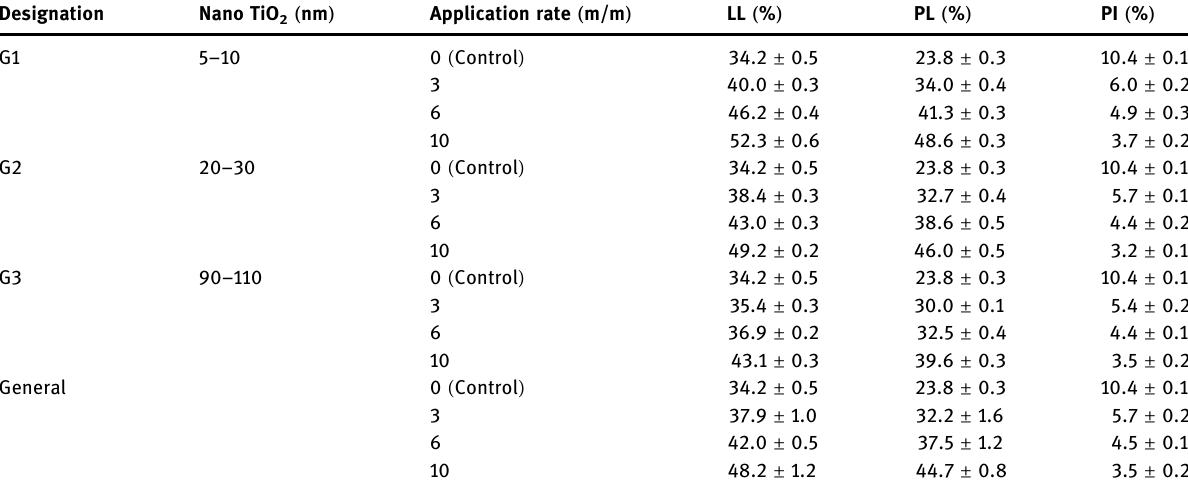
Table 4: E ff ect of nano TiO 2 application on liquid limit ( LL ) , plastic limit ( PL ) , and plasticity index ( PI ) of soil ( Mean ± SD a )